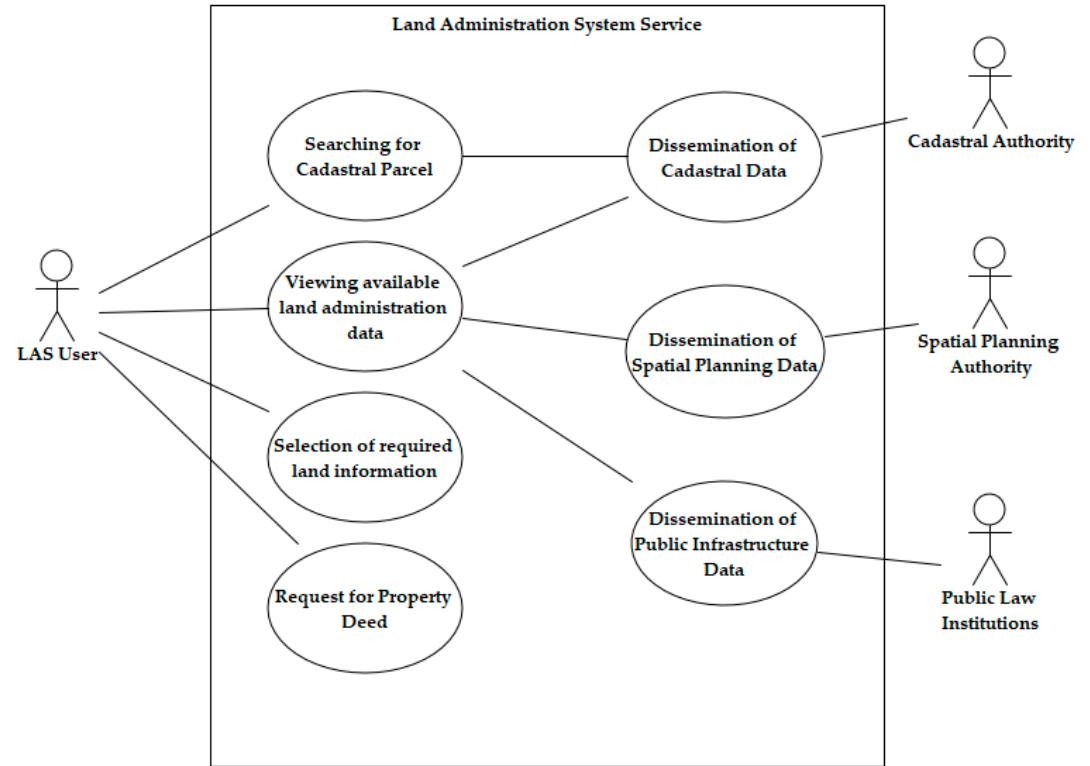
Figure 6. Use case diagram of the Property Deed data dissemination process. Source: Own compilation.